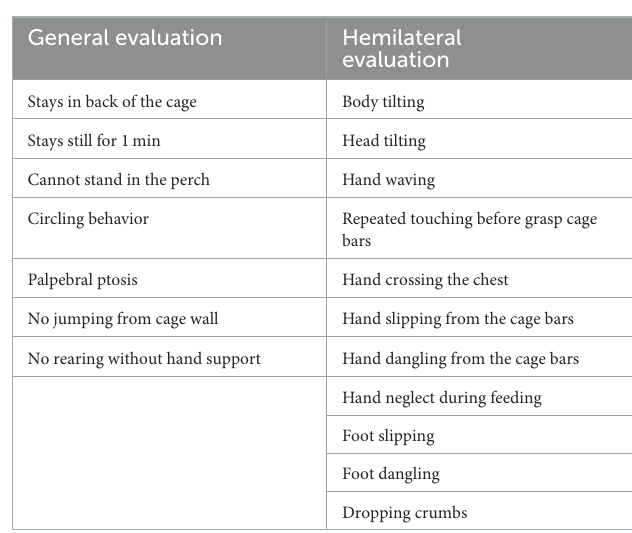
TABLE 2 Modified marmoset neurologic